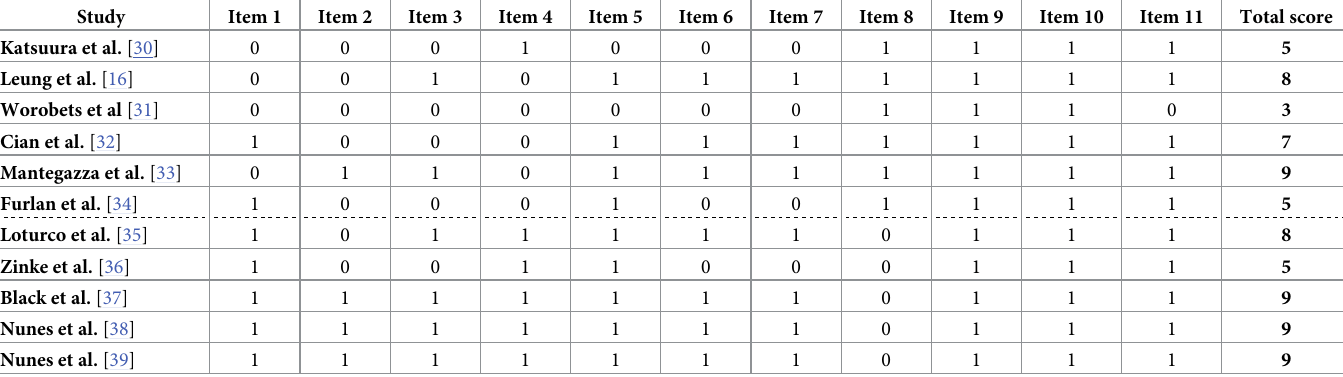
Table 2. PEDro scores for the selected